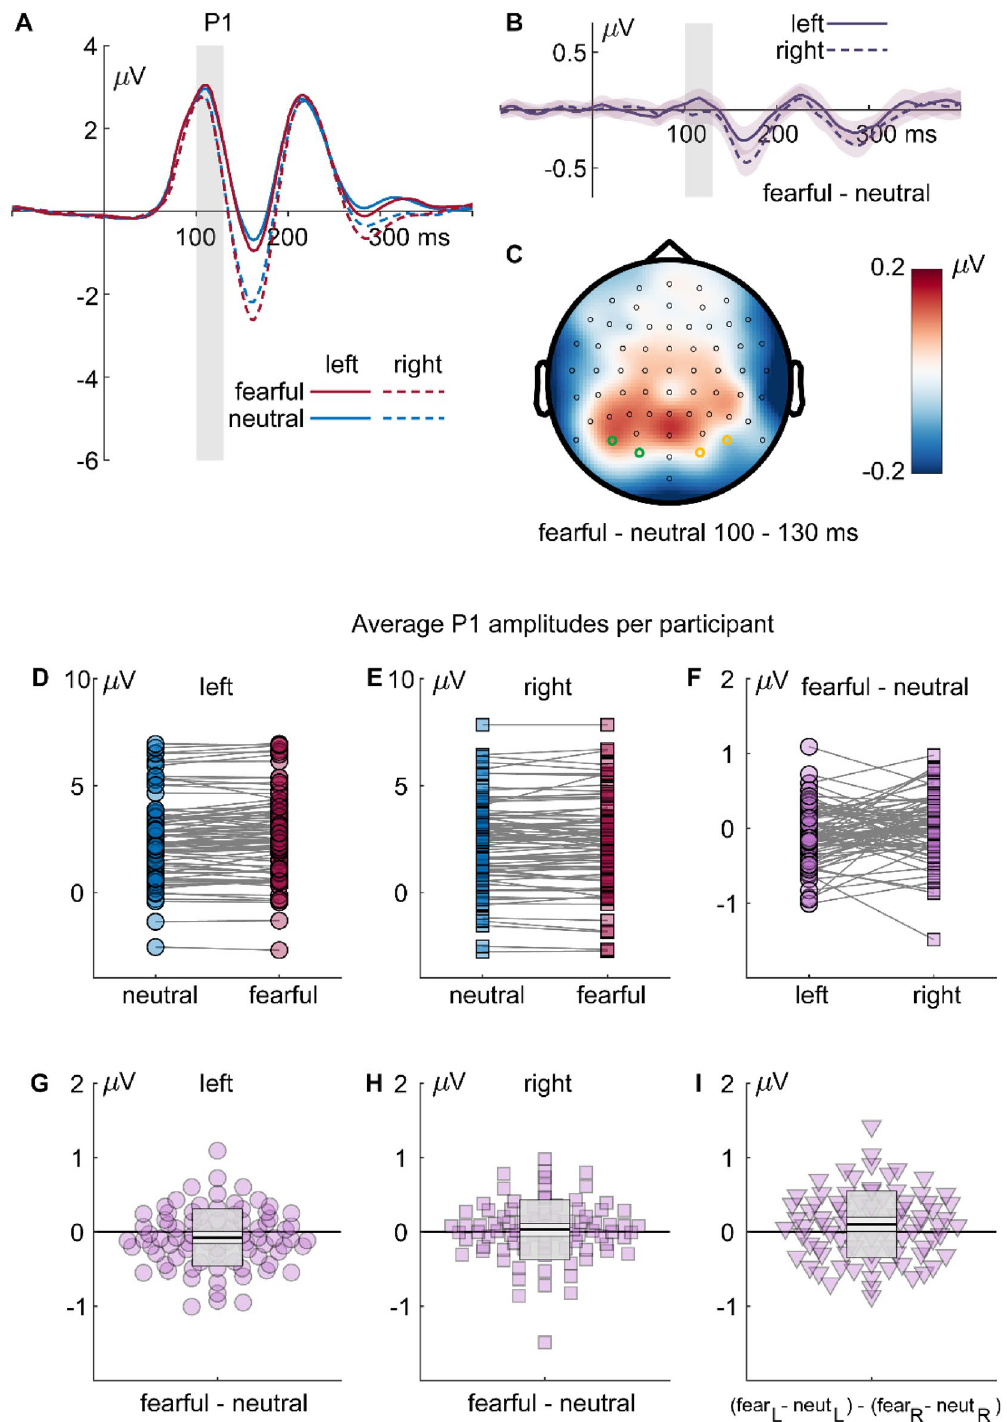
Figure 3. Results for the P1 component: ( A ) ERP waveforms for all fearful (red) and neutral (blue) expressions, separate for left (solid lines; PO7 and O1) and right (dashed lines; PO8 and O2) electrodes. ( B ) Differential ERPs (fearful–neutral; purple), separate for left (solid lines; PO7 and O1) and right (dashed lines; PO8 and O2) electrodes. The gray rectangles mark the interval of interest used for calculating average amplitudes and for the topography. Shaded areas around the differential ERPs depict the 95% bootstrap confidence intervals around the mean difference. ( C ) Topography of the differences in the highlighted interval of interest. ( D – F ) individual average P1 amplitudes or amplitude differences, respectively. ( G , H ) Individual differences between fearful and neutral faces and ( I ) individual left/right differences of fearful/neutral differences. The dots are horizontally displaced proportional to the local density to reduce cluttering. The superimposed gray boxes illustrate ± 1 standard deviation (SD; dark gray) and ± 1 standard error of measurement (SEM; light gray) around the mean (black